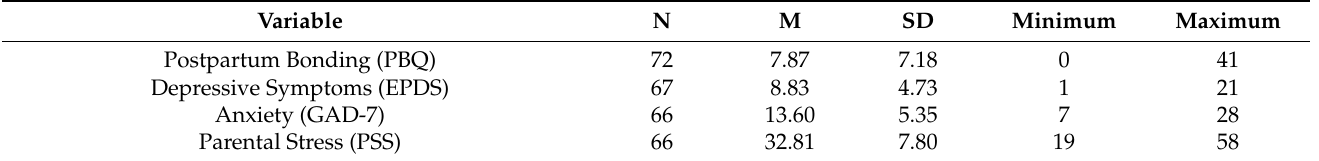
Table 3. Descriptive characteristics of PBQ, EDPS, GAD, and PSS.